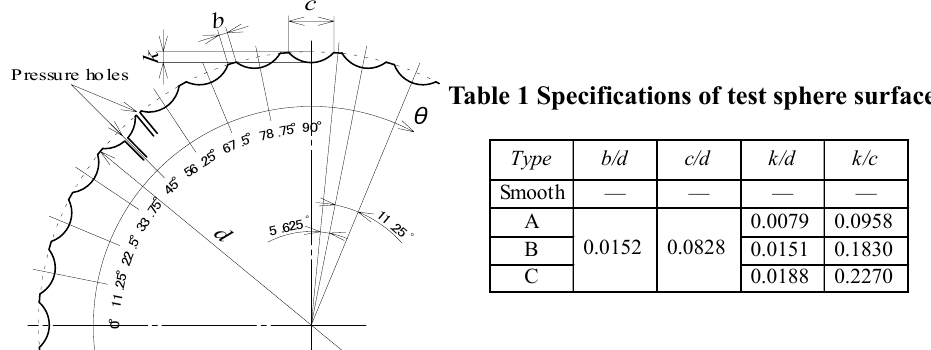
Fig. 1 Equatorial section of test sphere A blow-down type wind tunnel having a test section of 400 mm × 400 mm was used for aerodynamic measurements and flow visualization around the test sphere. The free stream velocity (U) was varied from 10 to 50 m/s. The turbulence intensity in this velocity range is 0.3 %. The Reynolds number ( Re = Ud/ ν , ν : kinematic viscosity) based on the free stream velocity and the diameter of the test sphere ranges from 0.4×10 5 to1.4×10 5 . Figure 2 (a) shows an outline of the equipment used to measure the drag ( D ). The dimensions of the frame were 500 mm × 500 mm, and the frame was placed 100 mm downstream from the outlet of the wind tunnel. The test sphere was fixed at the center of the frame using piano wire to provide tension at both fixed ends. The drag on the test spheres was measured by a three-component load cell with a strain gauge attached below the frame. Based on the measured drag and lift values, the drag coefficient ( C ) was calculated using Eq. (1). Figure D 2 (b) shows an outline of the equipment used to measure the pressure ( P ). The test sphere (